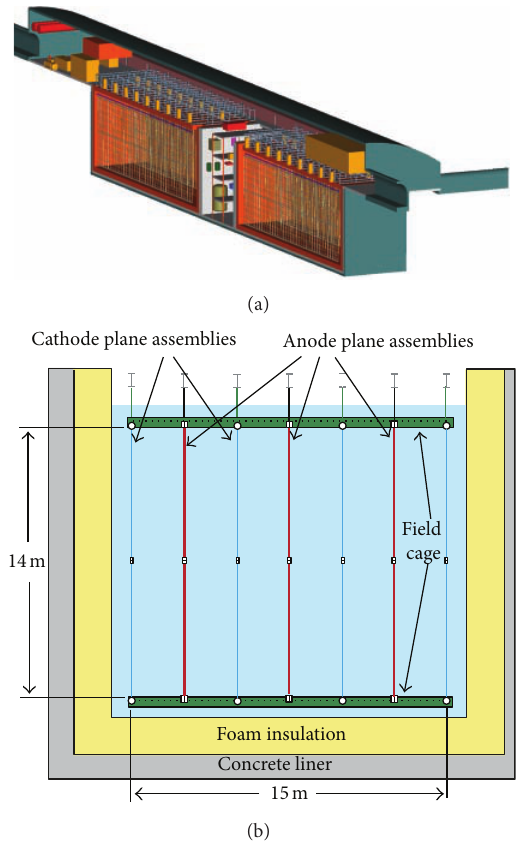
Figure 5: Detector configuration within the cavern. The TPC is located within a membrane cryostat, shown in orange. The interior dimensions of each cryostat are 24m wide × 18m high × 51m long. Thehighbayis150 mlongandhasa32 mspan.Cryogenicequipment is located in the septum area between the two cryostats. The right- hand side shows a cut view of the cryostat. The anode and cathode wire planes are hung from the ceiling of the cryostat. Each anode plane consists of 𝑢/𝑣 readout wires wrapped around a stainless steel frame and readout by electronics mounted on the planes.